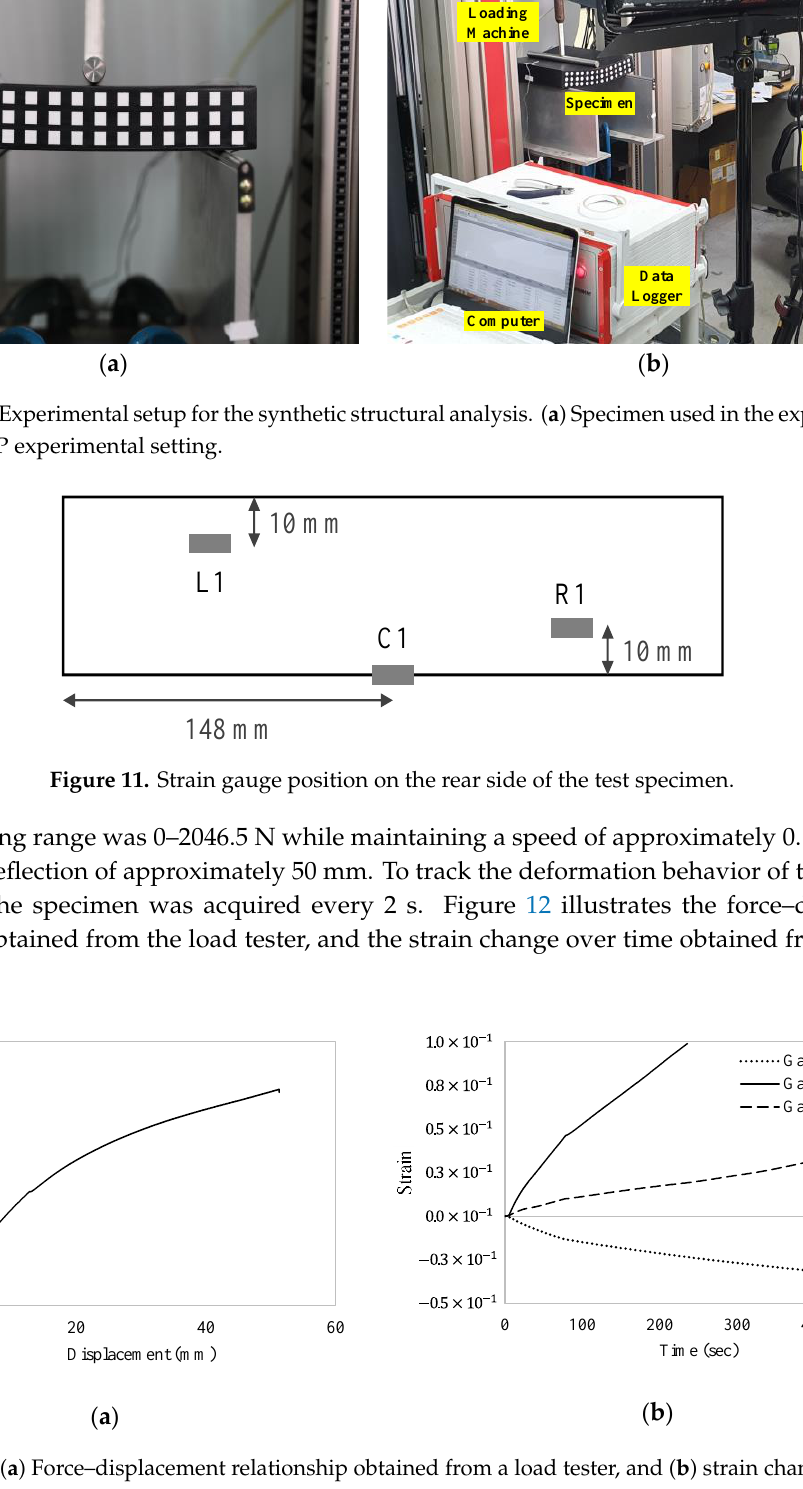
Figure 12. ( a ) Force–displacement relationship obtained from a load tester, and ( b ) strain changes over time obtained from strain gauges.